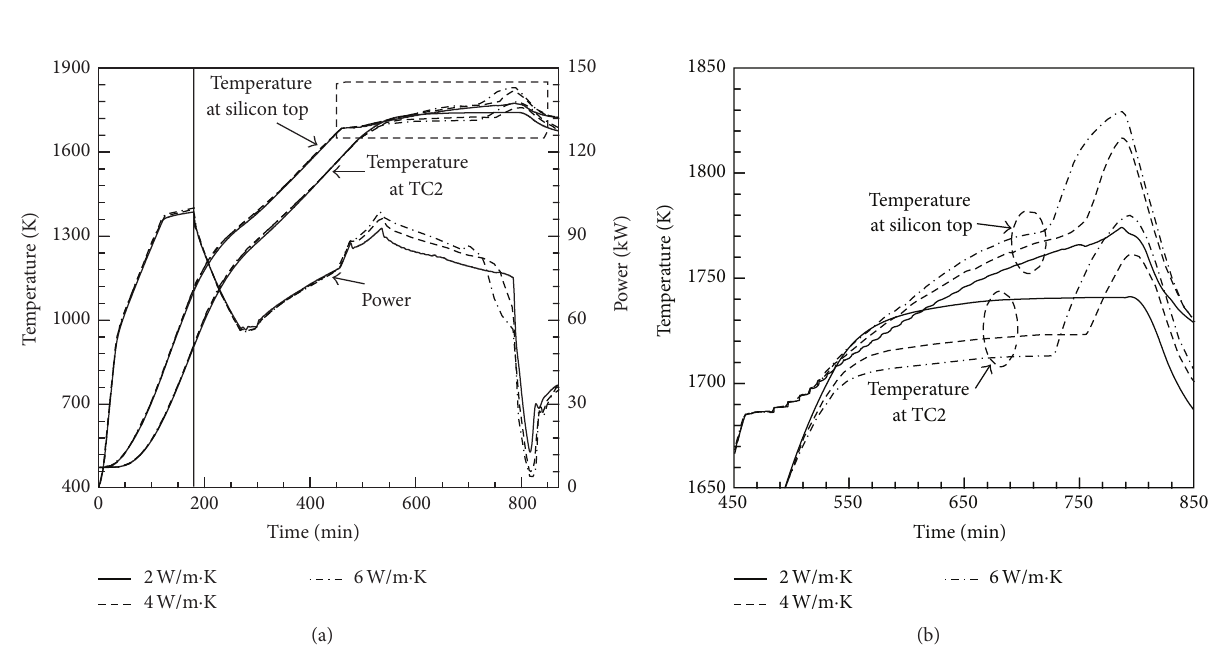
Figure 2: Evolution of process parameters during the heating and melting stages for DS processes with different crucible thermal conductivities: (a) evolutions of temperature and power; (b) partial enlarged view of the dashed rectangle in